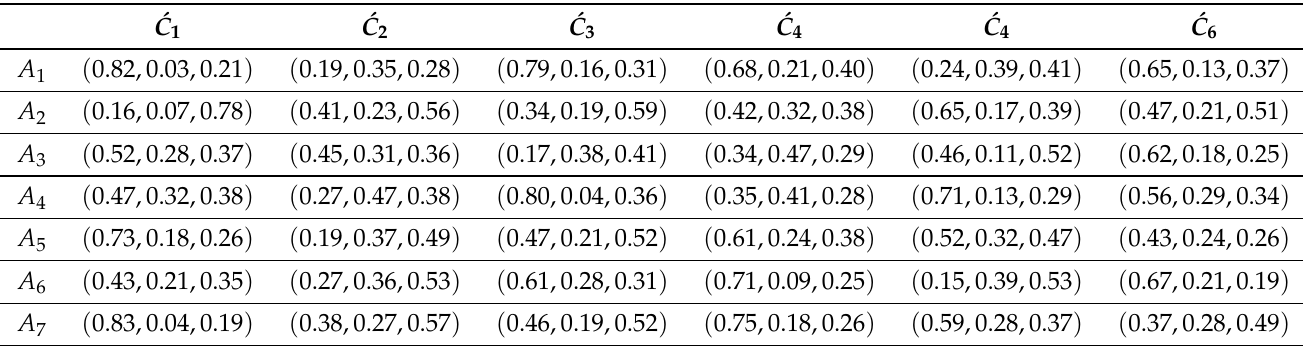
Table 12. Decision matrix D 1